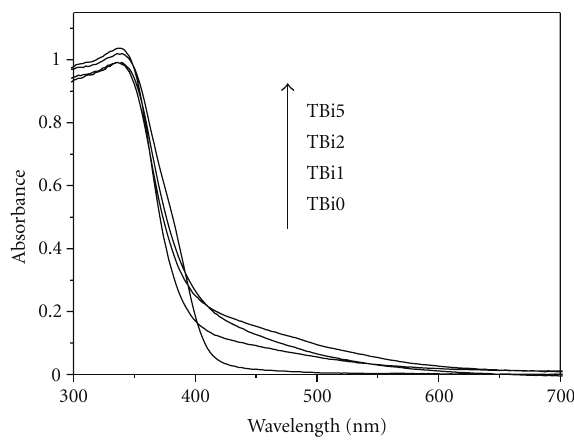
Figure 3: Di ff use reflectance UV-vis spectra of Bi-doped spherical TiO 2 and pure TiO 2